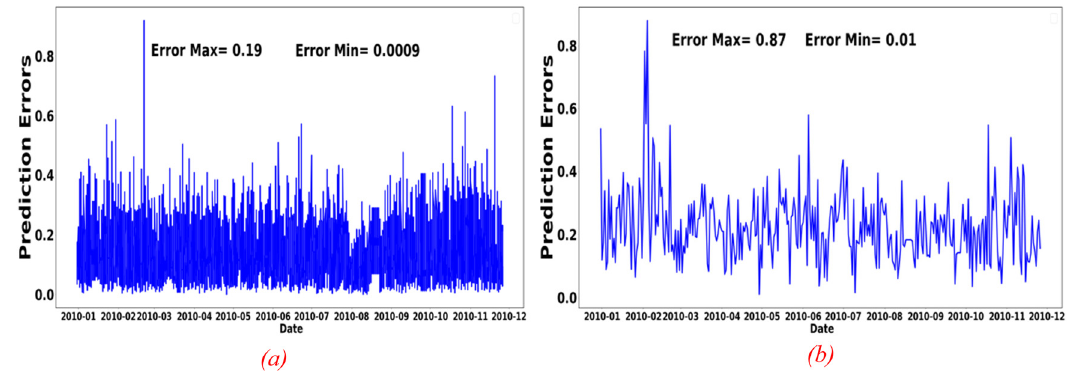
Figure 14: Household prediction errors of XGBoost model after feature normalization: ( a ) hourly granularity and ( b ) daily